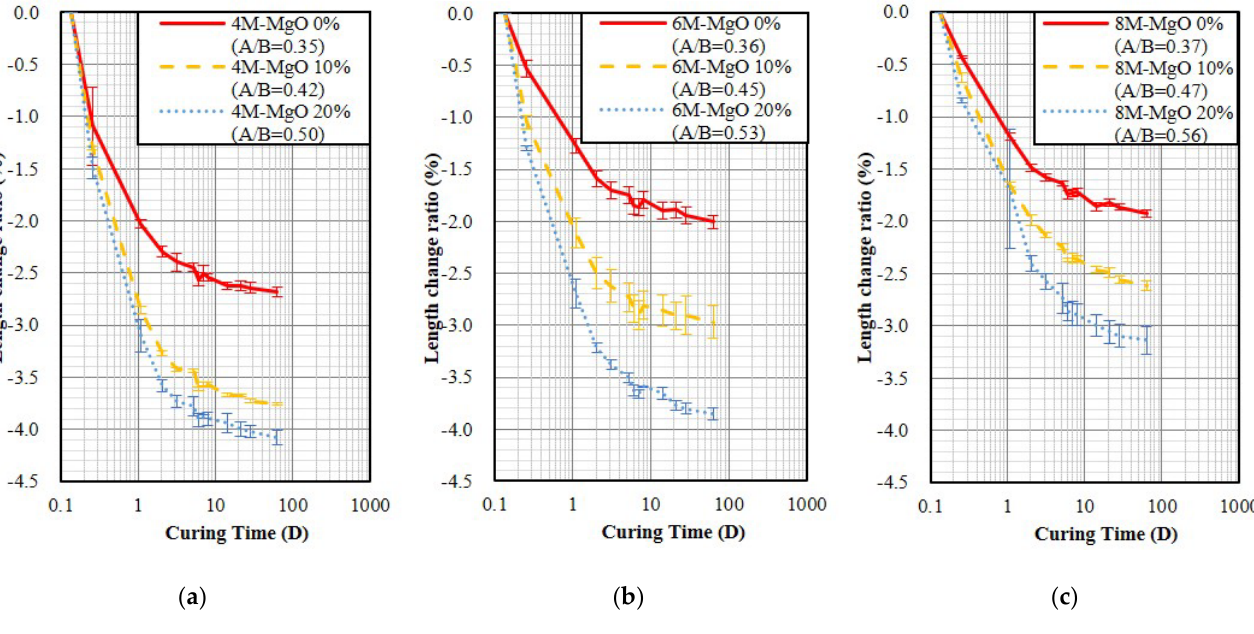
Figure 5. The length change ratios of the GP specimens fixed fluidity and demold at age of 3 h and then air-dry curing. ( a ) 4 M; ( b ) 6 M; ( c ) 8